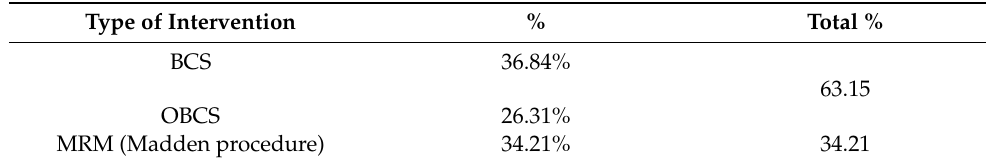
Table 5. Case classification based on surgery type for Group B.